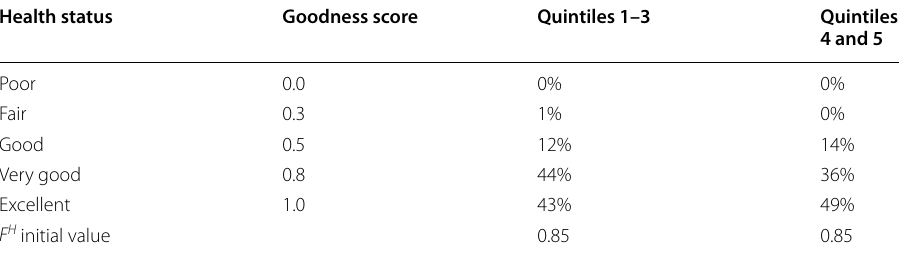
Table 5 Average percentage of children per socio-economic quintile by health status Health status